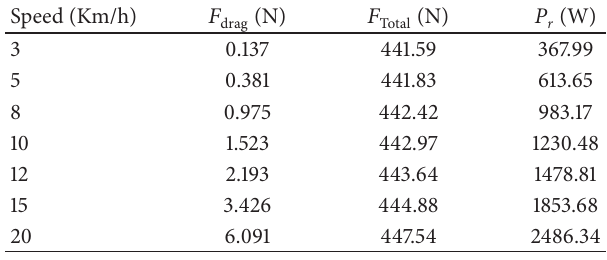
Table 5: Different drag forces with the variation of speed.